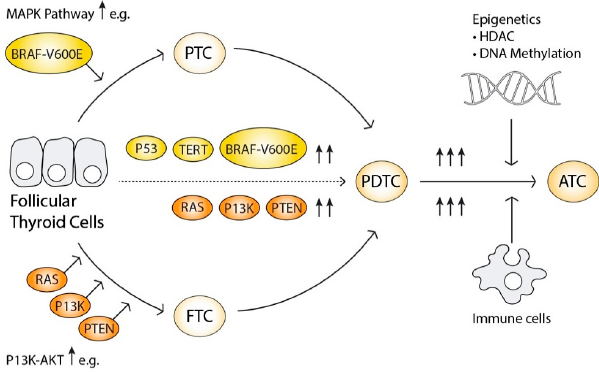
Figure 2. Illustration of the oncogenesis mode.